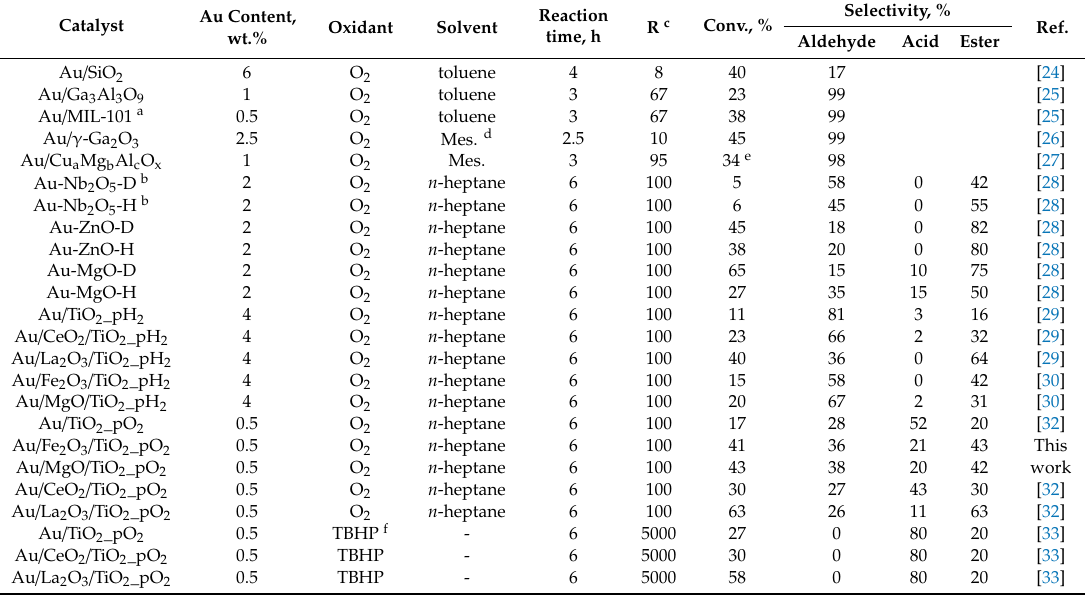
Selectivity, % Reaction c Conv., % time, h R